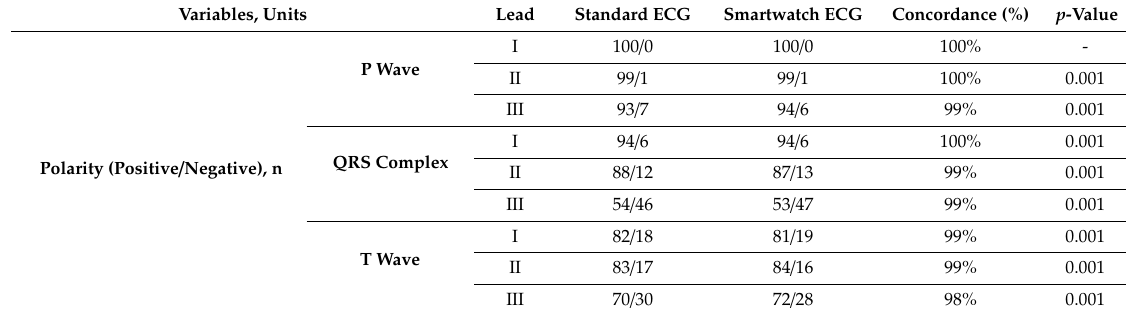
Table 3. Electrocardiogram characteristics